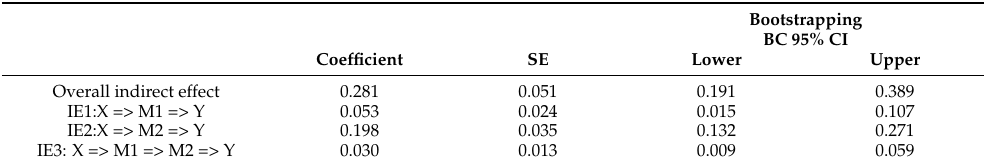
Table 3. Indirect effects of the serial multiple mediator model of the effect of interpersonal justice (X) on intra-role performance (Y) through resilience (M1) and job satisfaction